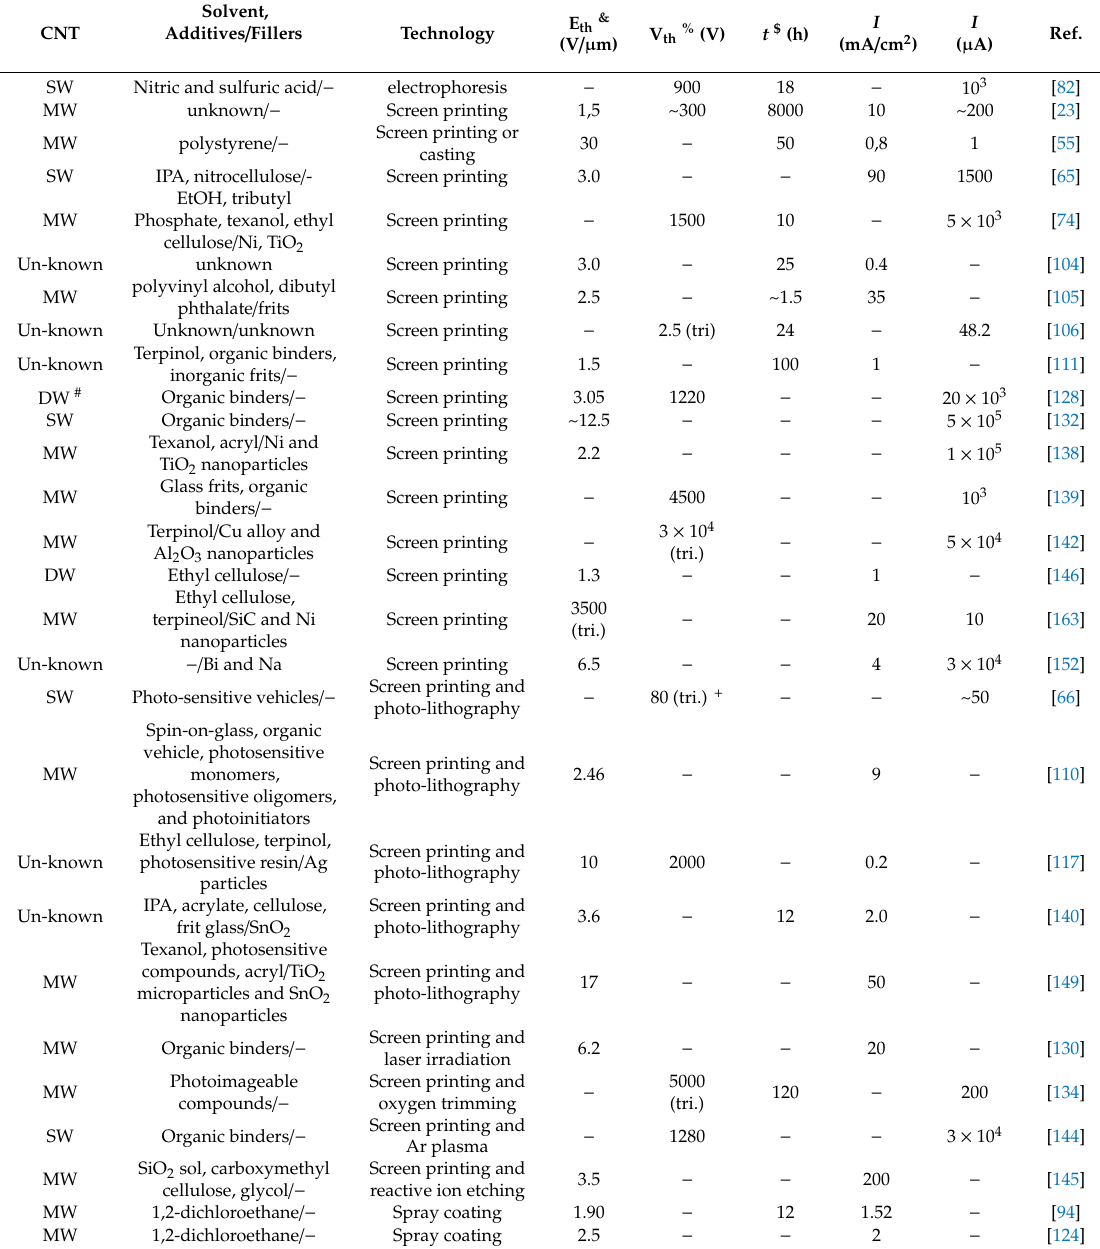
Table 1. The summary of the FE cathodes in a form of a film made of the suspension, grouped according the method to form a